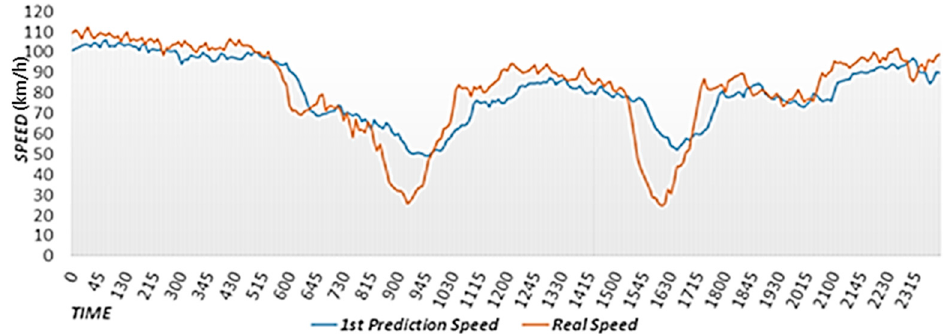
Figure 6. Graph of actual road speeds and primary predicted speeds over